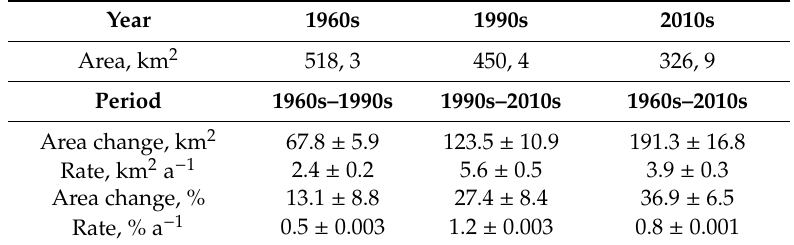
Table 5. Area and changes in the extent of clear ice in the Kuksu and Kunes river